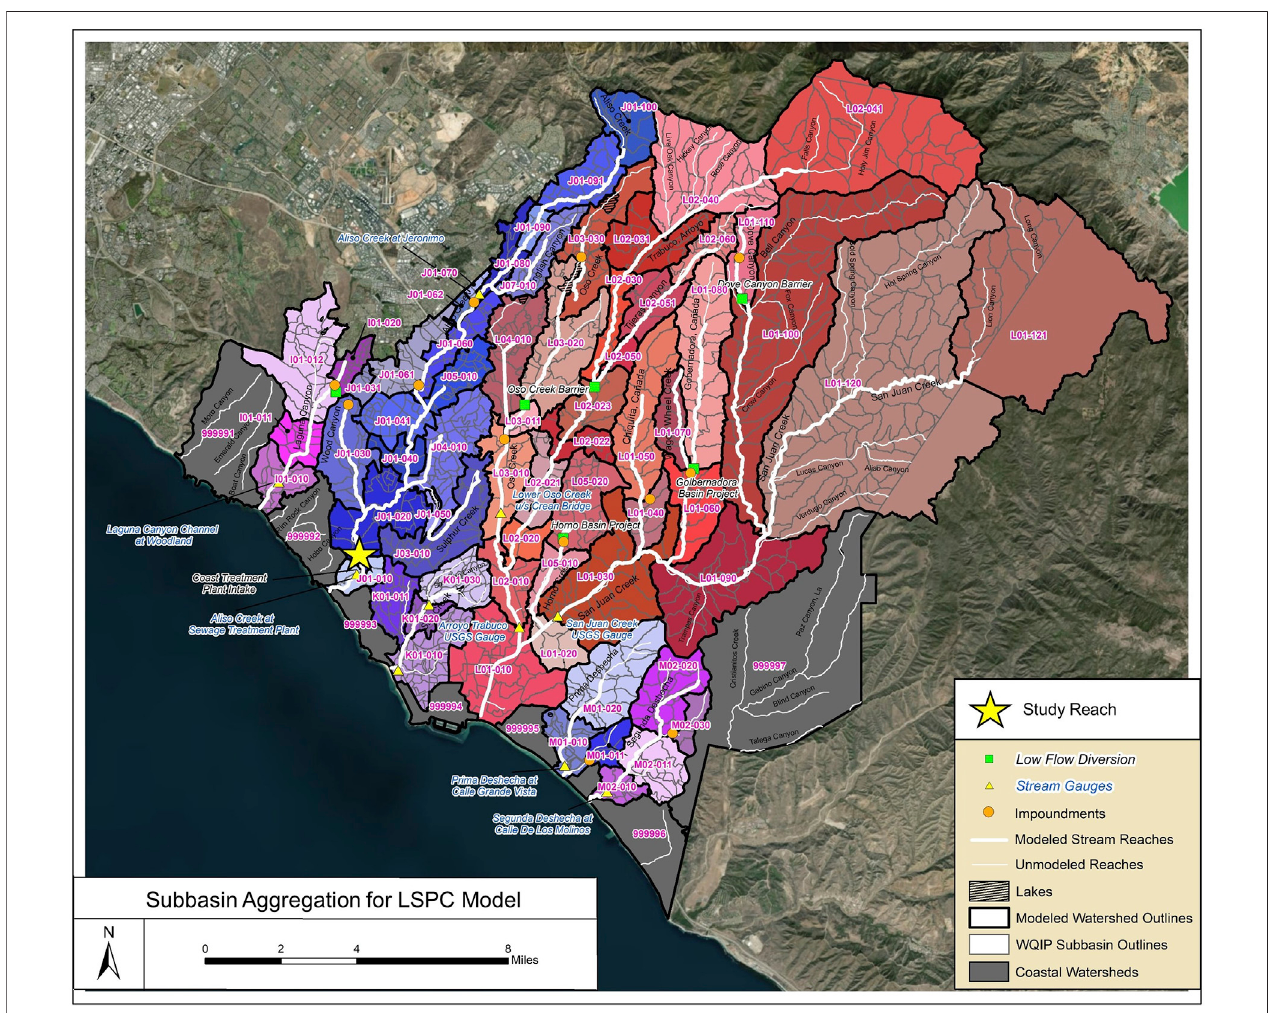
FIGURE 1 | South OC WMA with modeled subbasins. This study focuses on the high priority reach of Lower Aliso Creek (star).